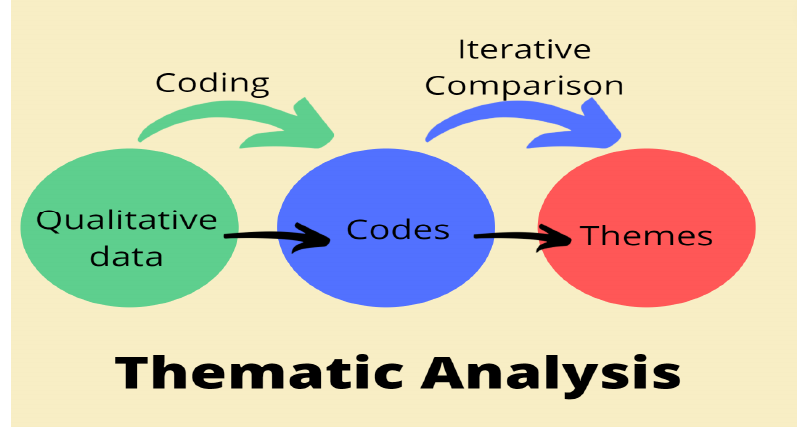
Figure 5. Thematic data analysis diagram.